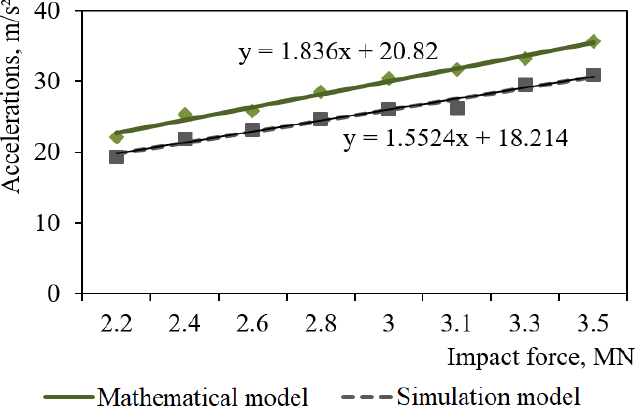
Figure 11. Accelerations on carrying structure of the open wagon at shunting impacts.